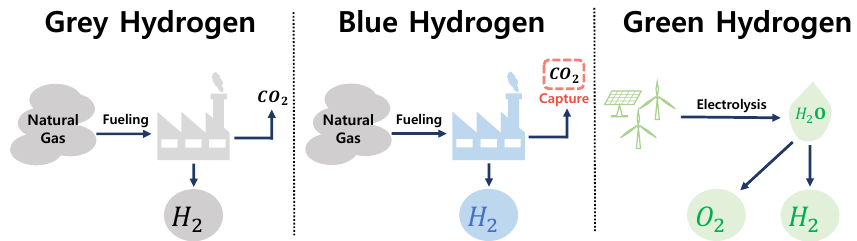
Figure 4. Classification by Hydrogen Production